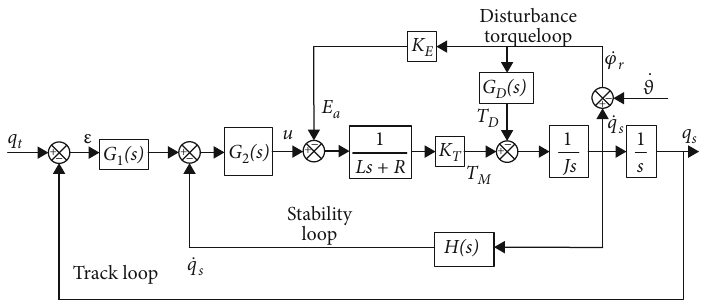
Figure 1: Structure of the pitch-yaw seeker.